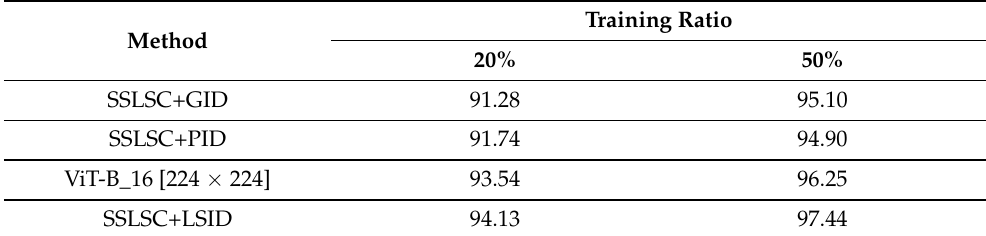
Table 5. OA (%) of experiment on AID with different pre-training